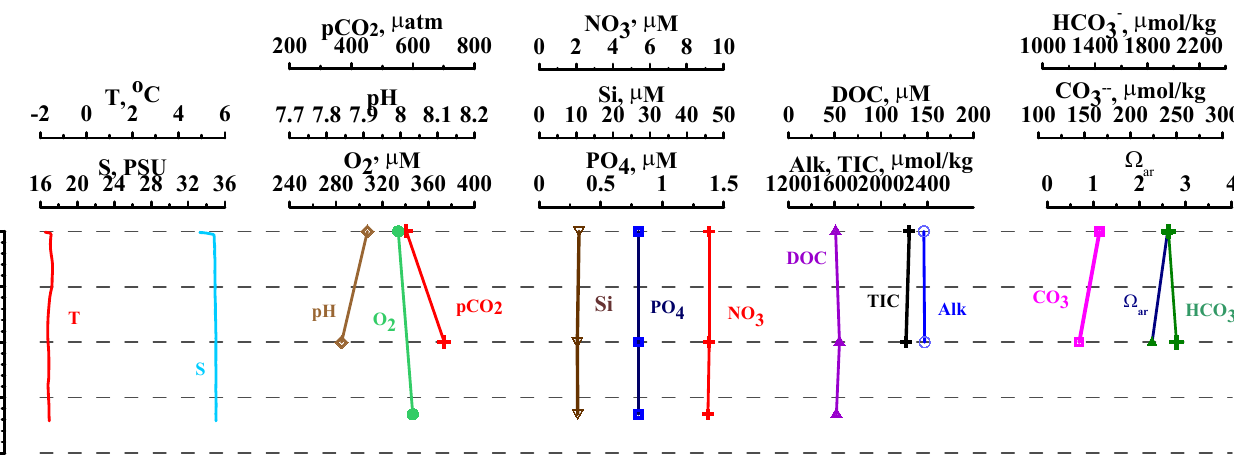
Figure A3. Vertical distribution of physical and chemical parameters at station TM1 (17 March 2014).